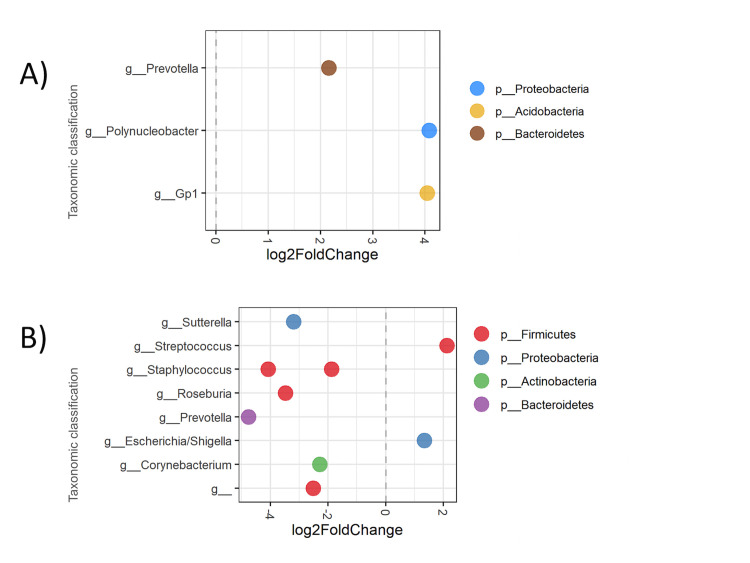
Differential abundance analysis according to weight adequacy.Each dot represents an individual OTU, organized by their Genus. (A) Differential abundance analysis according to weight adequacy at birth: Polynucleobacter (p = 0.0163), Gp1 (p = 0.018) and Prevotella (p = 0.038) were more abundant in meconium of preterm born AGA. (B) Differential abundance analysis according to weight adequacy for gestational age at discharge: Escherichia fergusoni (p = 0.014) and Streptococcus dentisani (p = 0.43) were more abundant in meconium of preterm AGA at discharge; Prevotella copri (p = 0.002), Roseburia inulinivorans (p = 0.003), Staphylococcus sp. (p = 0,003), Staphylococcus capitis subsp. Capitis (p = 0.004), Sutterella stercoricanis (p = 0.014), Corynebacterium tuberculostearicum (p = 0.033) and Ruminococcaceae (0.043) were more abundant in meconium of preterm SGA at discharge.